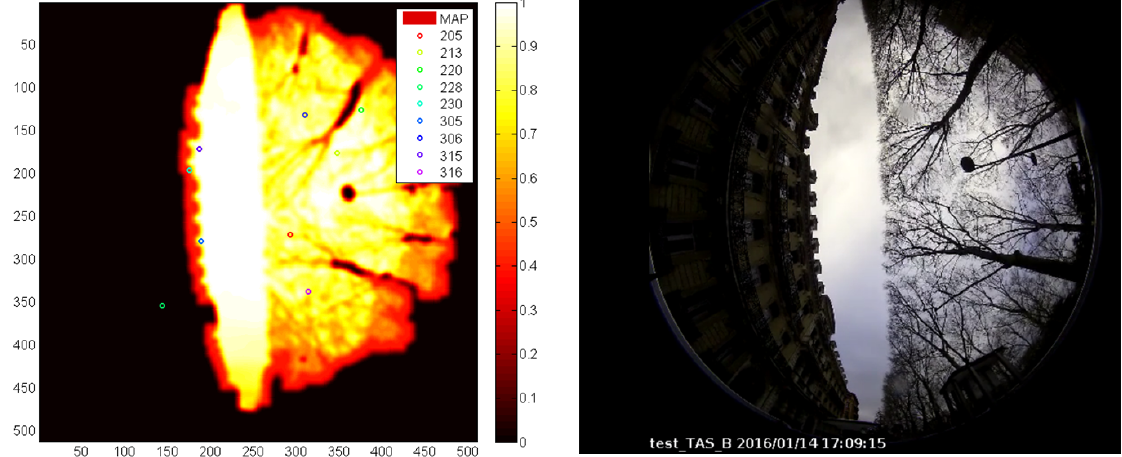
Figure 9. LoS MAP and video at timestamp 861.